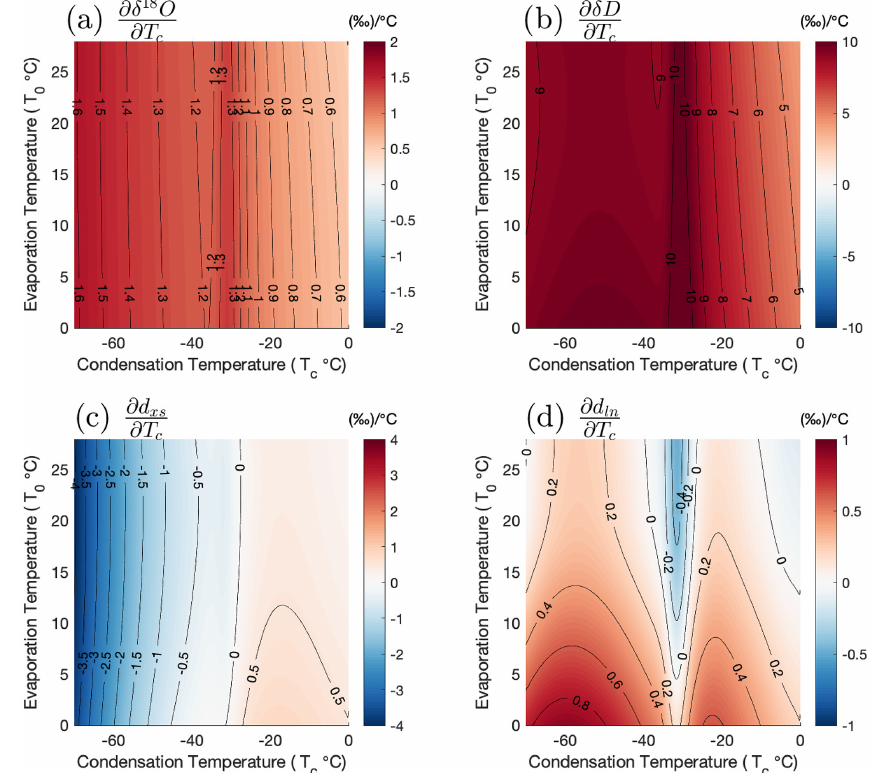
18 O , (b) ∂δ D , (c) ∂d xs , (d) ∂d ln . Shading ∂T c ∂T c ∂T c ∂T c